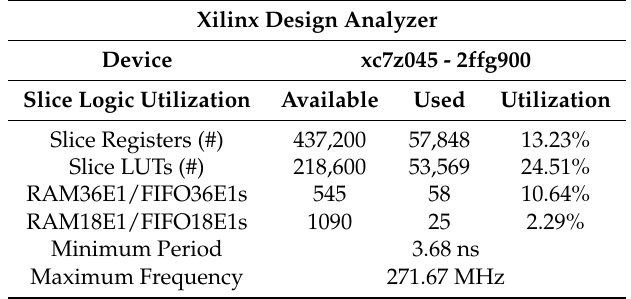
Table 10. Hardware synthesis result of the proposed visibility restoration algorithm.